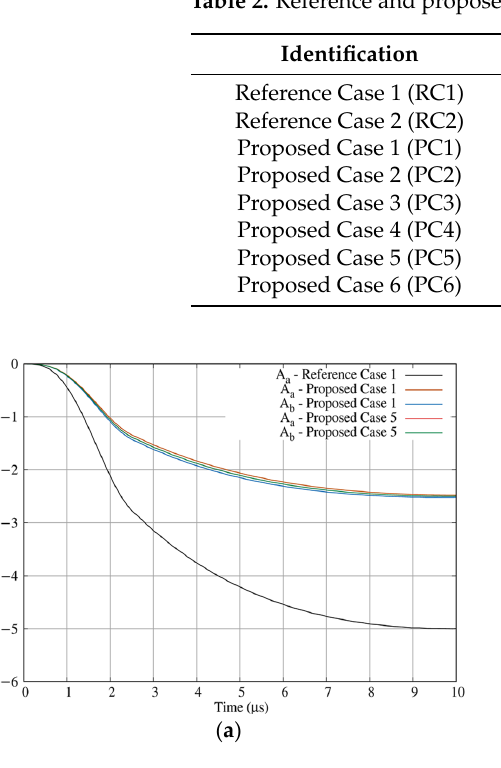
Table 2. Reference and proposed cases, which are numerically analyzed.